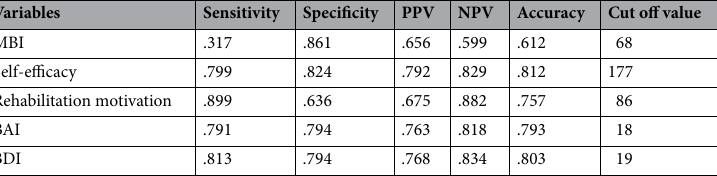
Table 3. Result of the CatBoost model based on emotion and ADL data. Abbreviations: ADL, activity daily living; PPV, positive predict value; NPV, negative predict value; MBI, modified bathel index; BAI, beck anxiety inventory; BDI, beck depression inventory.